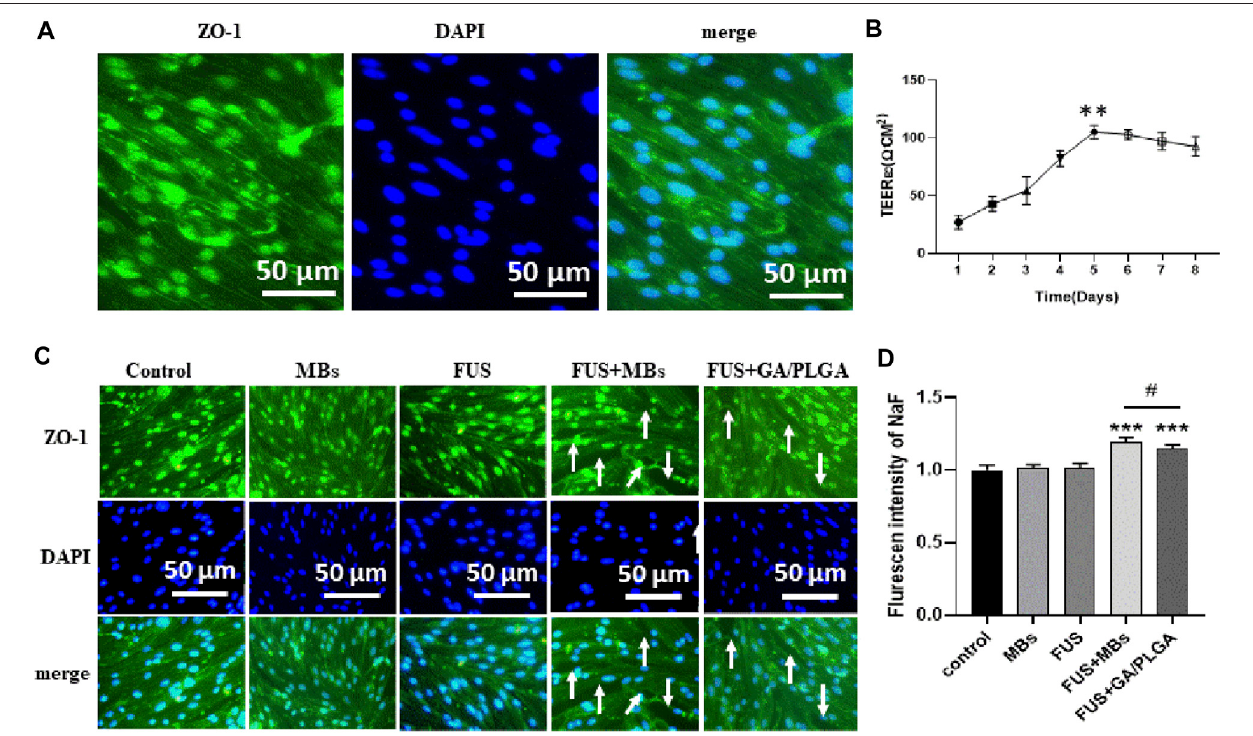
FIGURE 6 | (A) The in vitro BBB model. Blue indicates the nucleus and green indicates the ZO-1 tight junction protein. (B) Resistance change of the in vitro BBB model. The resistance value of the BBB model was 105.12 ± 4.92 Ω .CM 2 on the fi fth day (** p < 0.01 versus the other group). (C) L (Alexa Fluor488) fl uorescent secondary antibody labeled the ZO-1 tight junction protein. DAPI labeled the nucleus. FUS combined with lipid MBs or GA/PLGA MBs could open the BBB model, and thewhitearrowindicatesthatthetightjunctionpartwasalreadyopen. (D) FlorescentintensityofNaFintheFUS+MBsgroupwas1.19 ± 0.02(*** p < 0.001versus thecontrolgroup).FlorescentintensityofNaFintheFUS+GA/PLGAgroupwas1.19 ± 0.02(*** p < 0.001versusthecontrolgroupand # p < 0.05versustheFUS+MBs